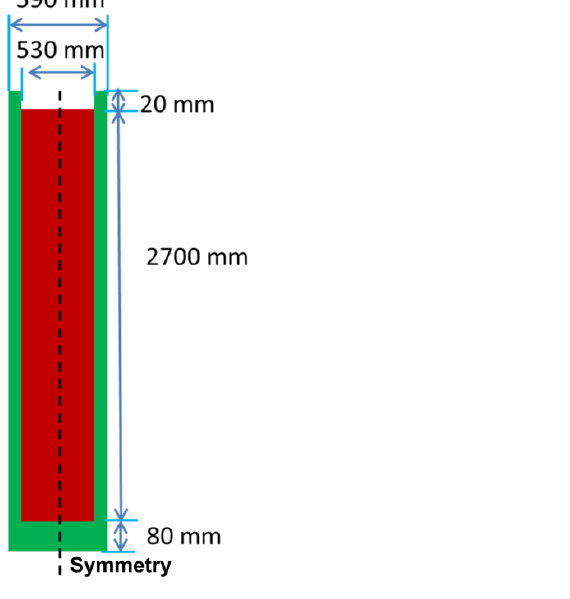
Figure 7. The geometry and dimensions of the simulated NbTi ingot. Table 1. The main thermo – physical parameters used in the current simulations.